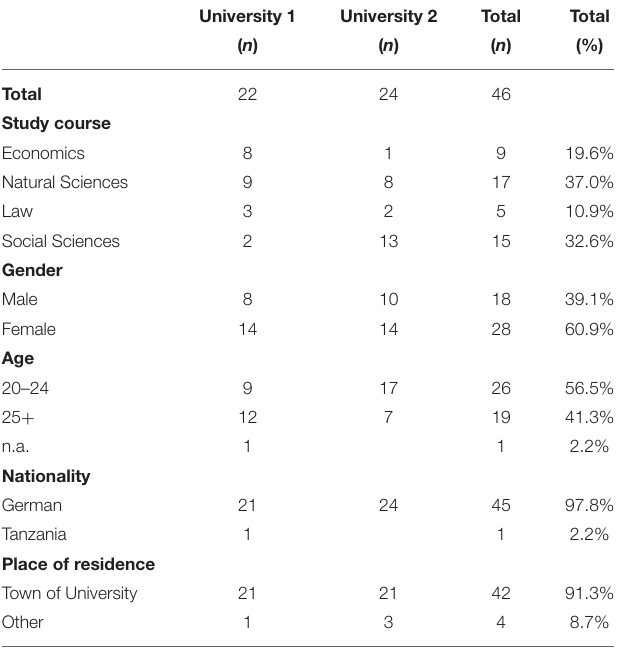
TABLE 1 | Sociodemographic data of the participants.